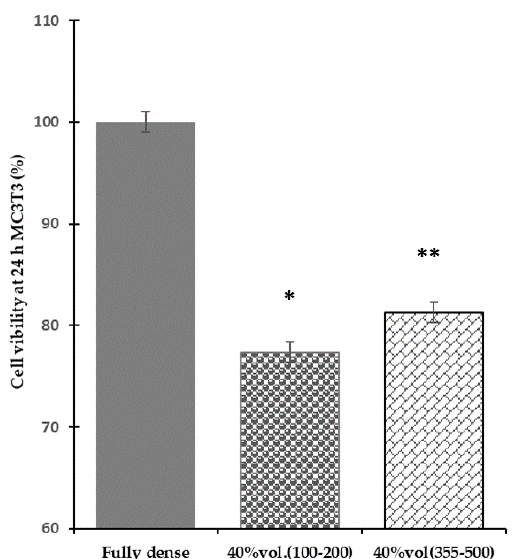
Figure 3. Cell metabolic activity in adhesion stage determined by AlamarBlue assay of MC3T3 cell line at 24 h. (* p < 0.05 fully-dense vs. 40 vol.% (100–200 µ m) and ** p < 0.001 fully-dense vs. 40 vol.% (355–500 µ m)).